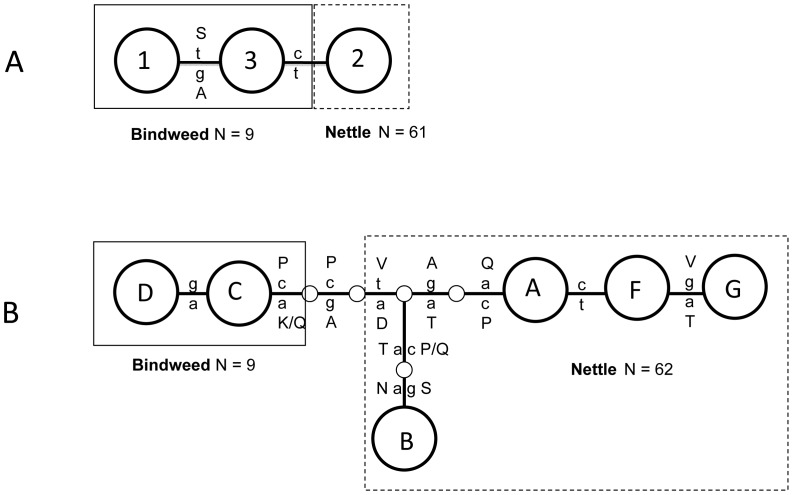
Haplotype networks for genotypes of stol-11 and secY.The networks of stol-11 (A) and secY (B) show all genotypes observed in tuf-a (nettle) associated strains and in nine random, comparative tuf-b (bindweed) strains. Lower case letters: nucleotide substitutions; upper case letters: amino acid substitutions. The corresponding SEE-ERANET nomenclature of the secY genotypes is shown in Appendix S3.